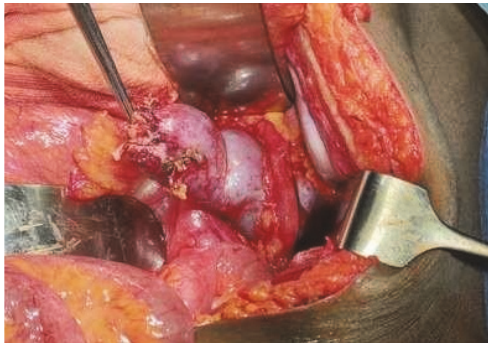
Figure 4: Intraoperativepicture of exploratory laparotomy showing small residual stump of lower pole of right kidney fused to the lower pole of left kidney. Left ureter is seen running over the lower pole of left kidney.